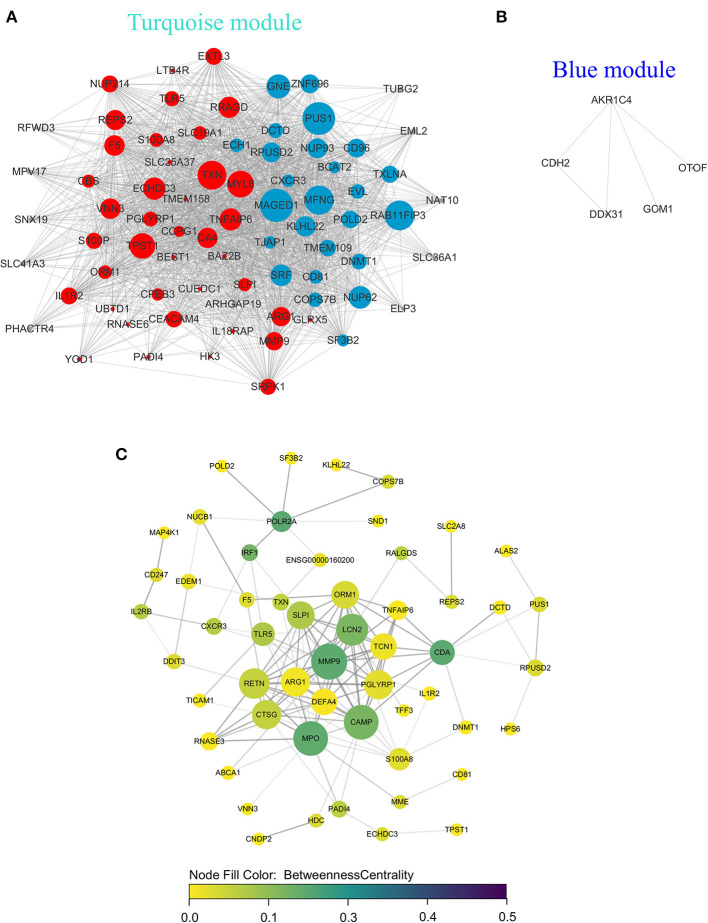
Network analyses of module genes/hub genes recognized by WGCNA at transcriptional and protein levels. In gene co-expression network of turquoise module (A), blue module (B), the red/blue circles represented up/downregulated module genes, respectively, and the gray circles represented module genes that were not differentially expressed; larger node size is associated with increased number of edges. (C) In protein–protein interaction network of hub genes, the node size (from small to large), node color (from yellow to green), and transparency of edges (from light to dark) were proportional to degree centrality (number of edges possessed by a node), betweenness centrality (the frequency that a node serves as a bridge along the shortest path between two other nodes), and combined score (evidence of interaction between two nodes based on different evidence channels, e.g., experimental data/association in curated databases), respectively.